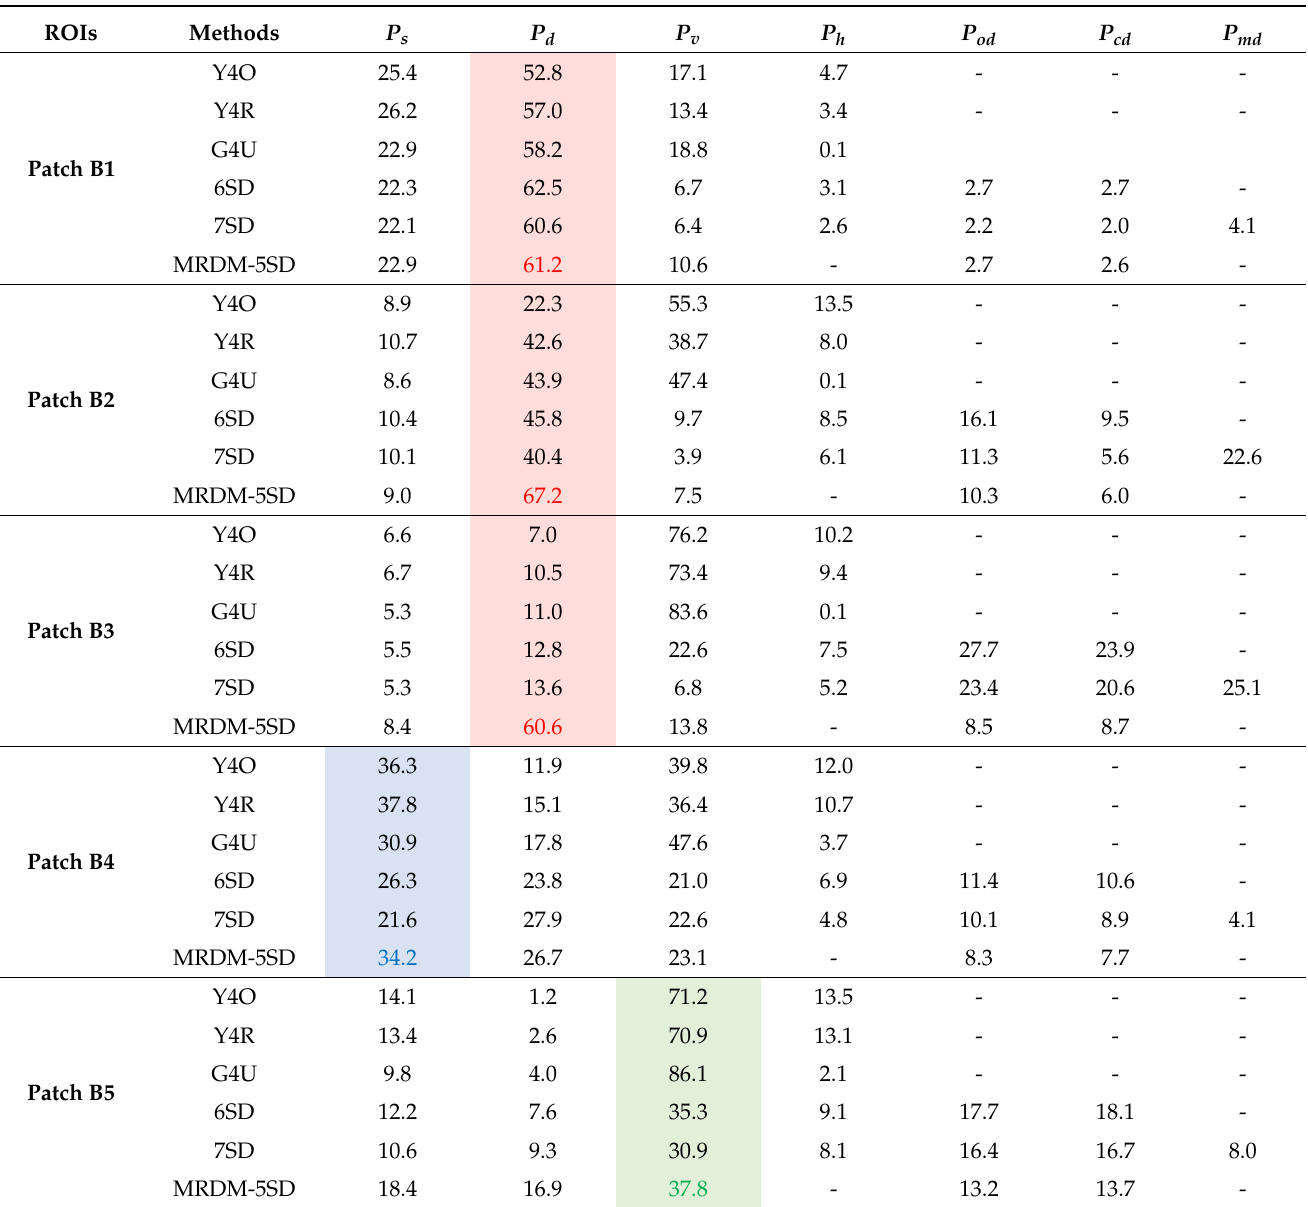
Table 3. Scattering contributions (%) of Patch B1-B5 for GF-3 data sets.